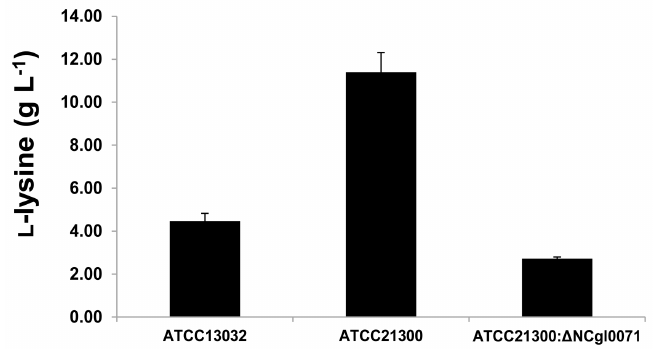
Figure 4. L -Lysine production of Corynebacterium glutamicum ATCC13032, ATCC21300, and the bioB mutant (of ATCC21300). Values shown are averages based on results obtained from at least three independent experiments, in which the standard deviation was <5%.